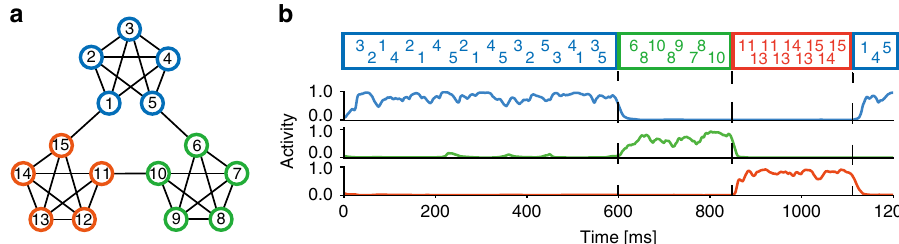
Fig. 5 Detection of temporal community. a The input sequence represented a random walk with uniform transition probabilities on a graph with community structure (modi fi ed from ref. 5). b Normalized responses of three output neurons to input sequences de fi ned in a are shown.